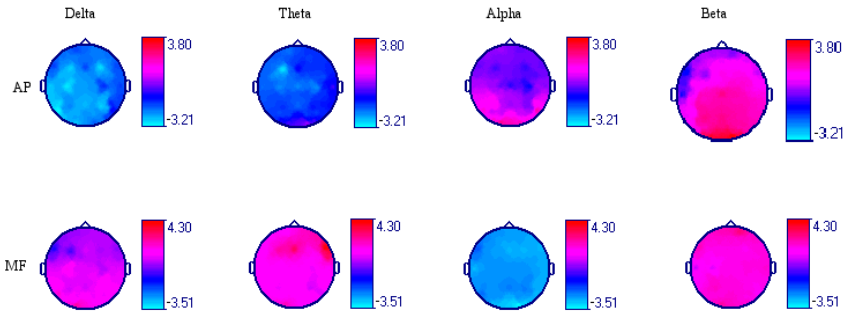
Figure 2. Comparison of the Absolute Power (AP) and the Mean Frequency (MF) of the EEG frequency bands before and after the acute dark chocolate intake. The T values are observed with a significance threshold of − 1.73 to 1.73 ( p = 0.05, n = 20, ANOVA-test).